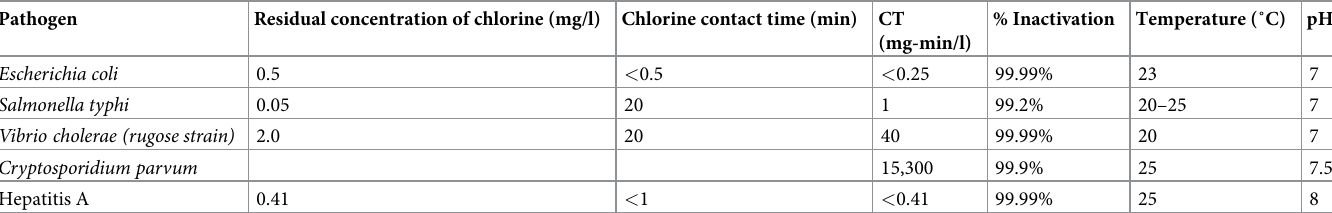
Table 5. Chlorine CT values for selected pathogens, adapted from Centers for Disease Control and Prevention (2012) [72].